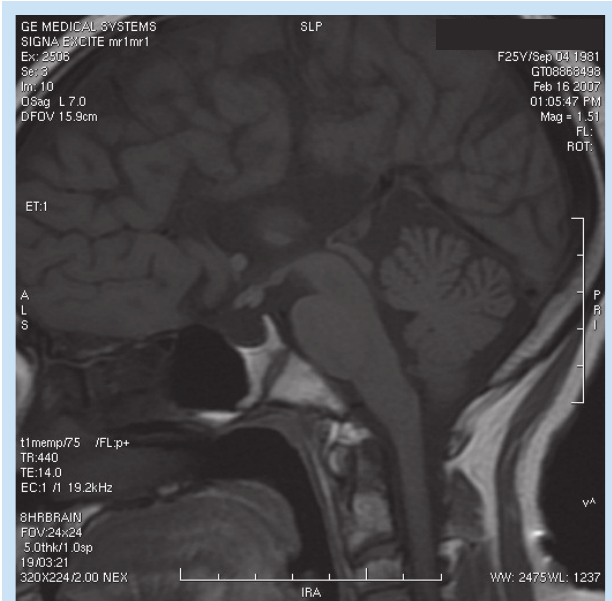
Fig. 1. A sagittal T1W post-contrast MRI scan demonstrating the hyper- intense posterior pituitary gland outside the sella and along the pathway of the stalk. The pituitary stalk is not visualised. The adenohypophsis is hypoplastic.